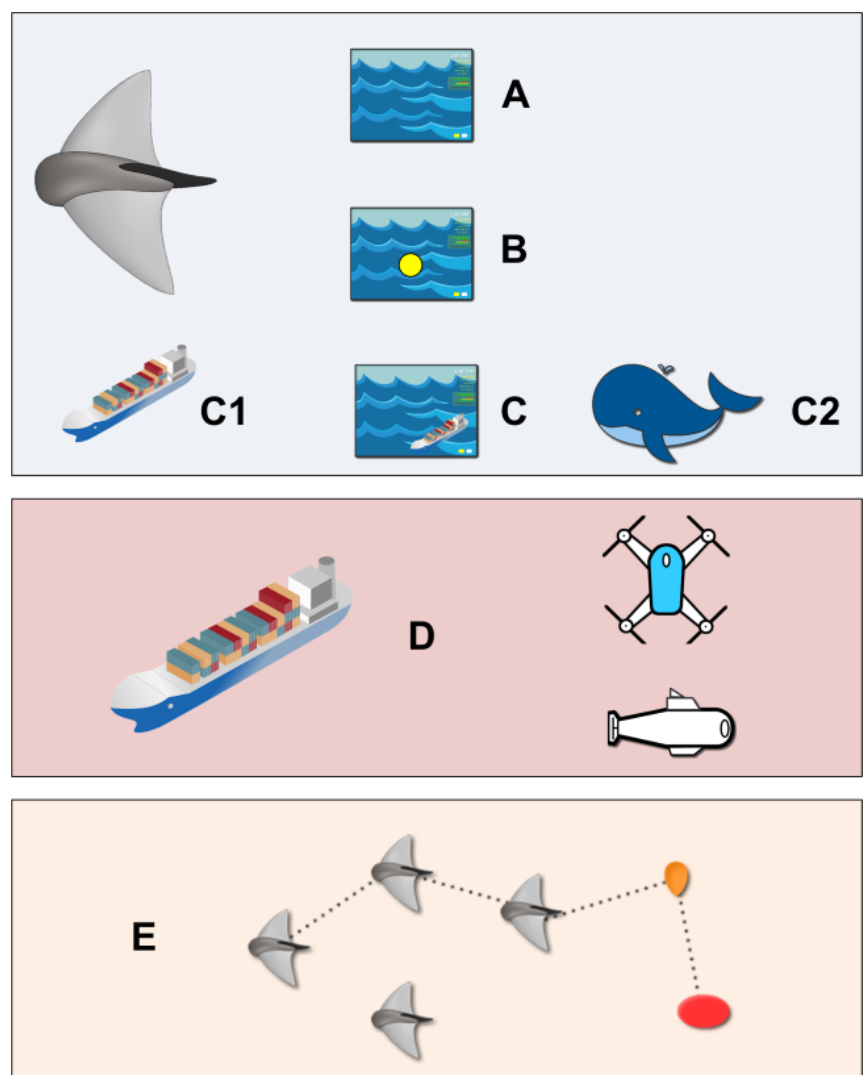
Figure 13. Edge AI services operations flow.